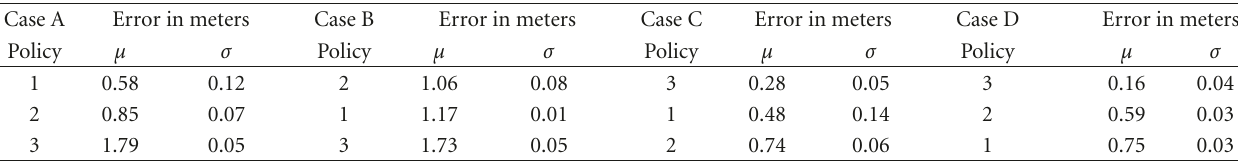
Table 4: Results of the 2D-simulated soccer simulation experiment showing a list of the policies ordered from best (top) to worse (bottom) based on the estimator error for the four di ff erent experimental cases. Every result is statistically significant (based on t